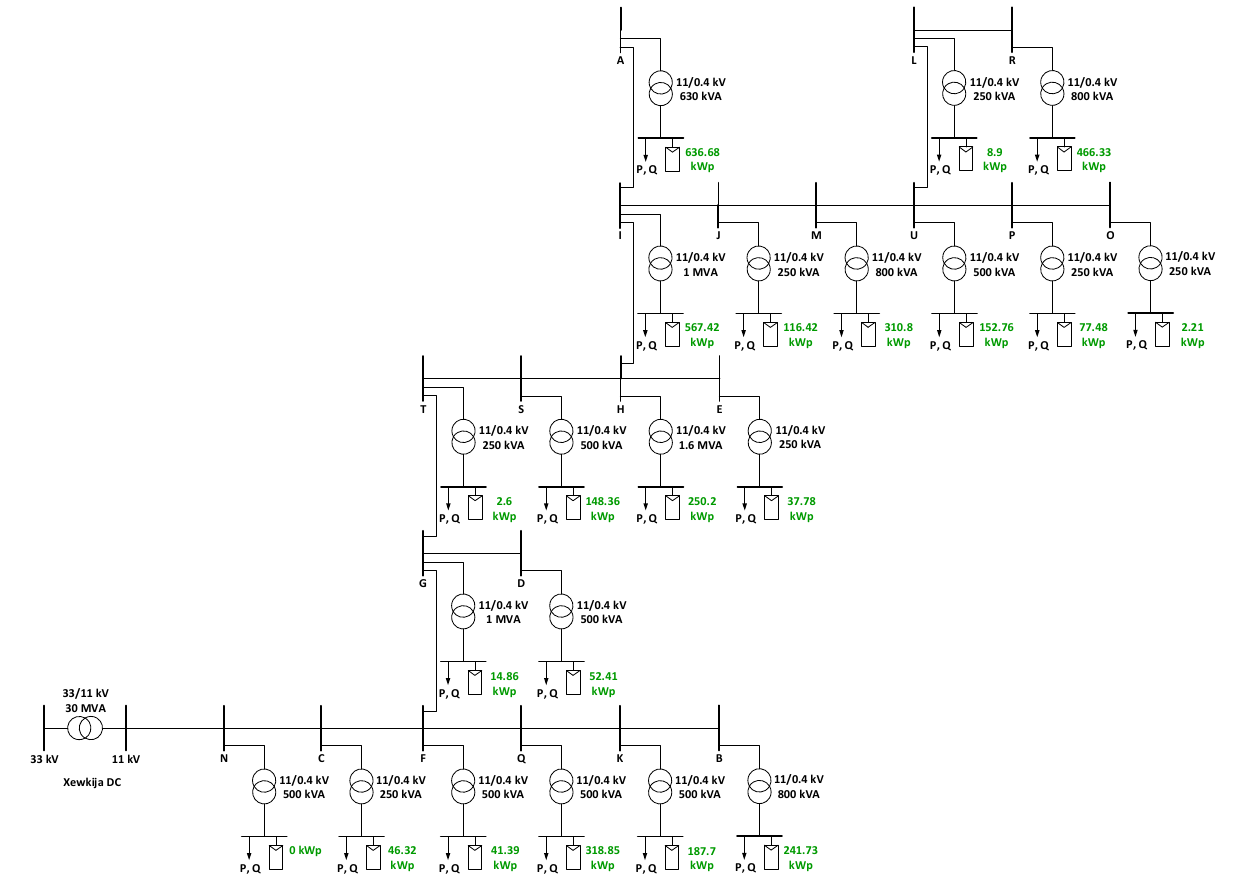
Figure 3. Line diagram of the considered feeder section including the installed PV capacity at each secondary substation.